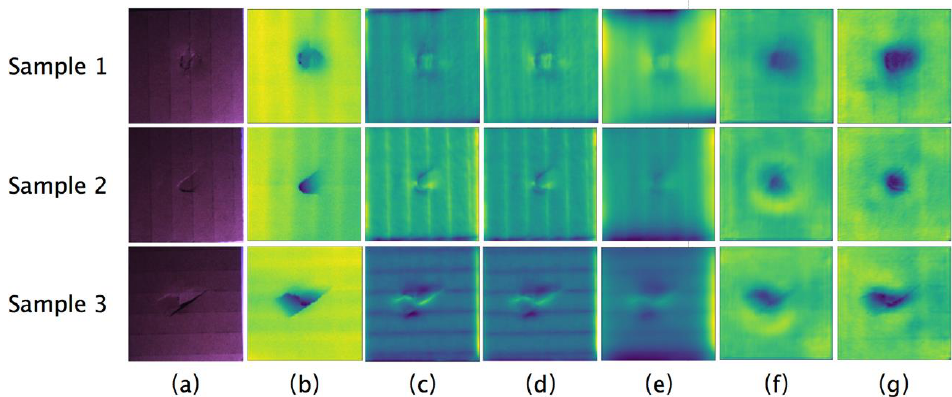
Figure 5. Examples of the results of our method and others. The samples in the example are all from the test set: ( a ) the first column shows the basic 2D information of this sample; ( b ) the corresponding ground truth data (calculated using linear structured light scan) are shown in the second column; ( c – e ) the third to fifth columns demonstrate the classic multi-source Photometric Stereo approach using 5,10, and 20 input images; ( f ) the sixth column shows the results using a general L2 loss function; ( g ) the result estimated by our network is shown in final column.